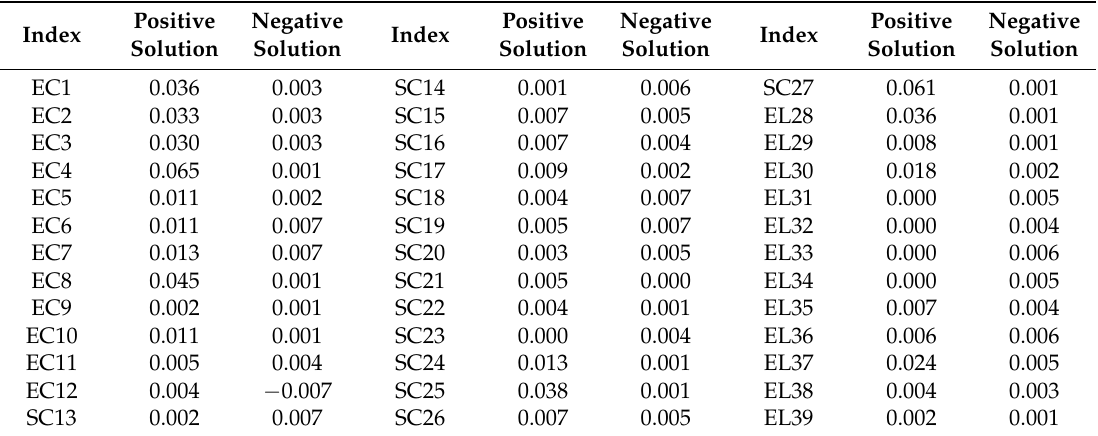
Table 5. Positive and negative ideal solutions for each index.